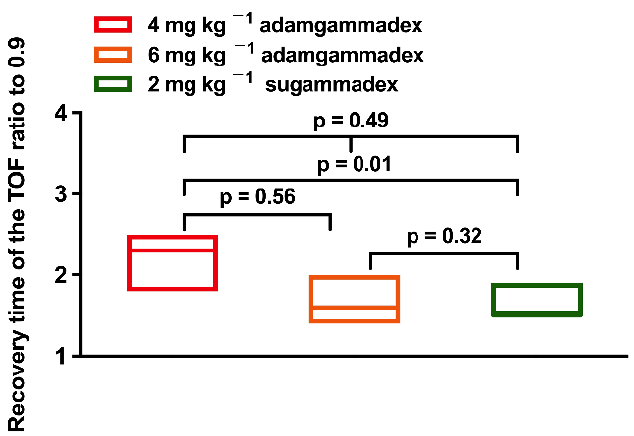
Figure 3. Time from start of administration of adamgammadex or sugammadex at the reappearance of T 2 to the recovery of the TOF ratio to 0.9 (full analysis set).